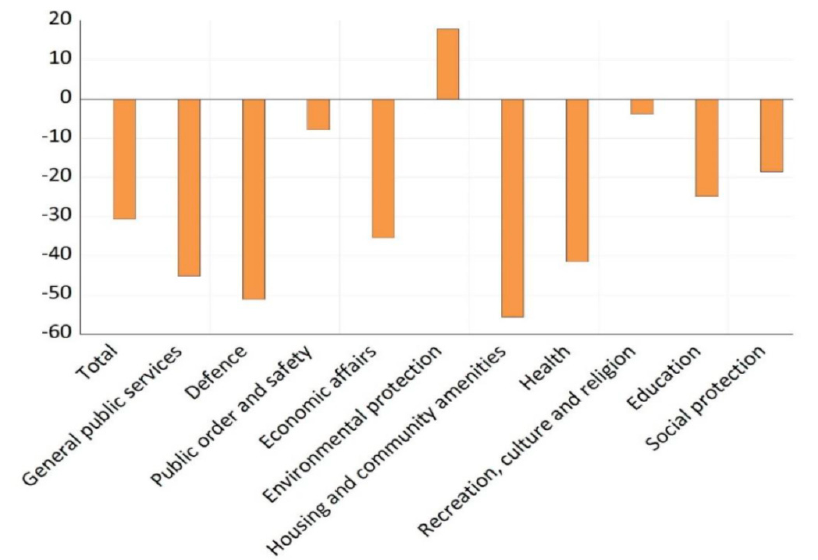
Figure 1. Percentage Change in Government Expenditure by Function, 2009–2018. Source: Eurostat.